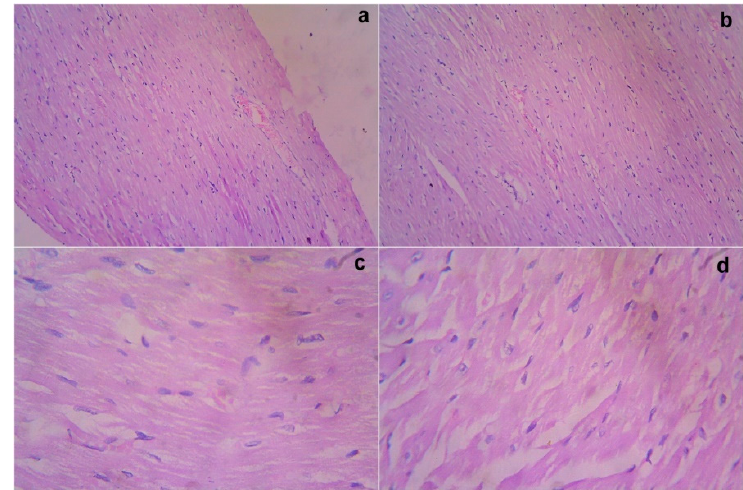
Figure 4. Gross histopathological examination of the heart following the infusion of mesenchymal stem cells obtained from decidua basalis in Wistar albino rats to assess the impact of safety, efficacy, and acute toxicity. Representative images of the heart section stand for ( a ) 10 × showing the congregation of blood vessels, ( b ) 10 × showing myocardium with myocytes, ( c ) 40 × showing myocardium with myocytes showing mild edema, and ( d ) 40 × showing the myocardium with myocytes showing mild edema, respectively.